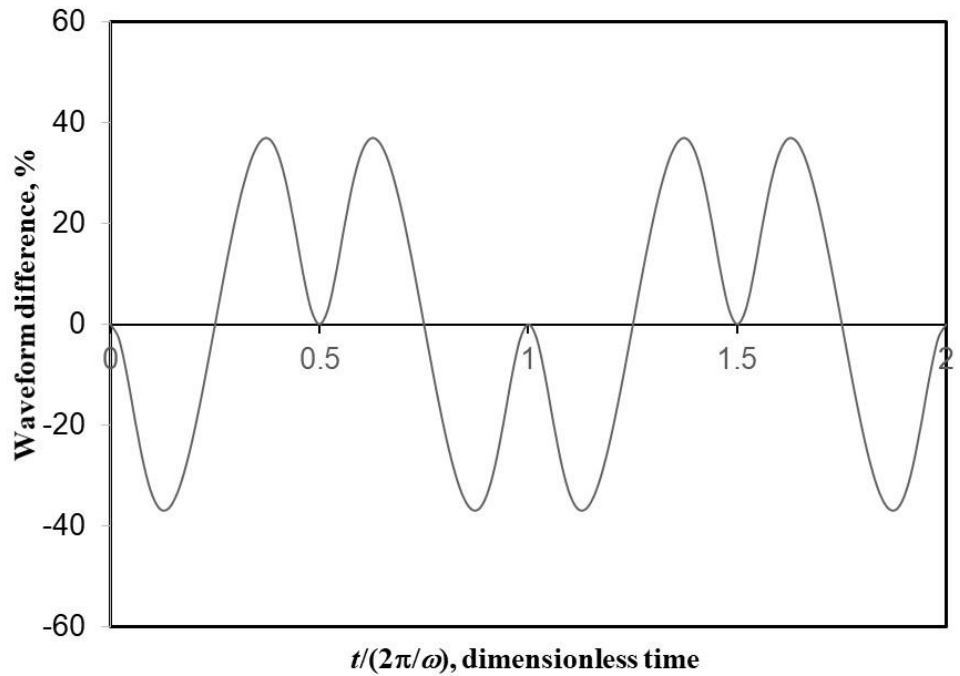
Figure 11. Difference between elliptic cosine and simple cosine ( c/a = 0.5, k = 50, w/w o = 3, ξ = 0.02, single cavity, nonlinear solution).